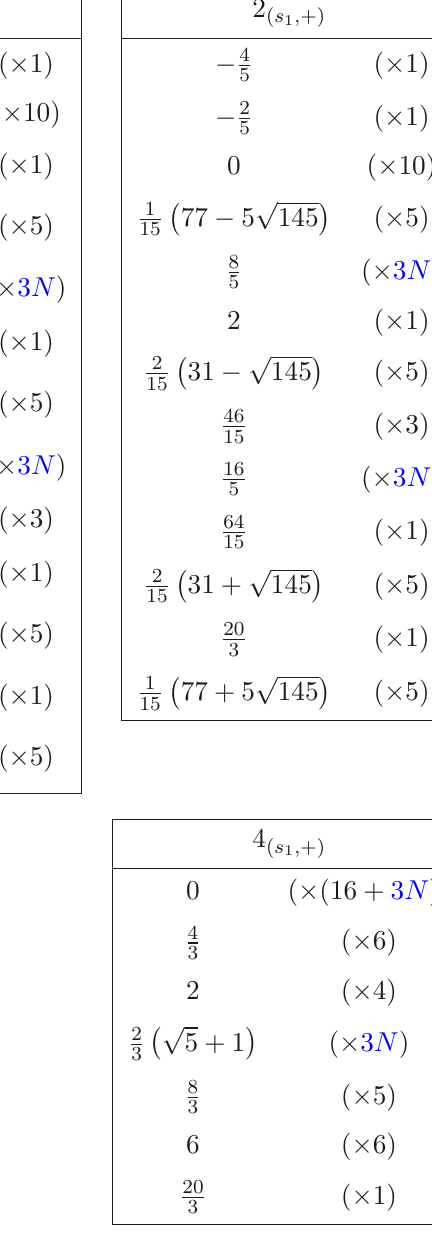
Table 7 . Normalized masses for the solutions in the extended theory with s 2 = +, in increasing order. The masses related to the open-string sector are shown in